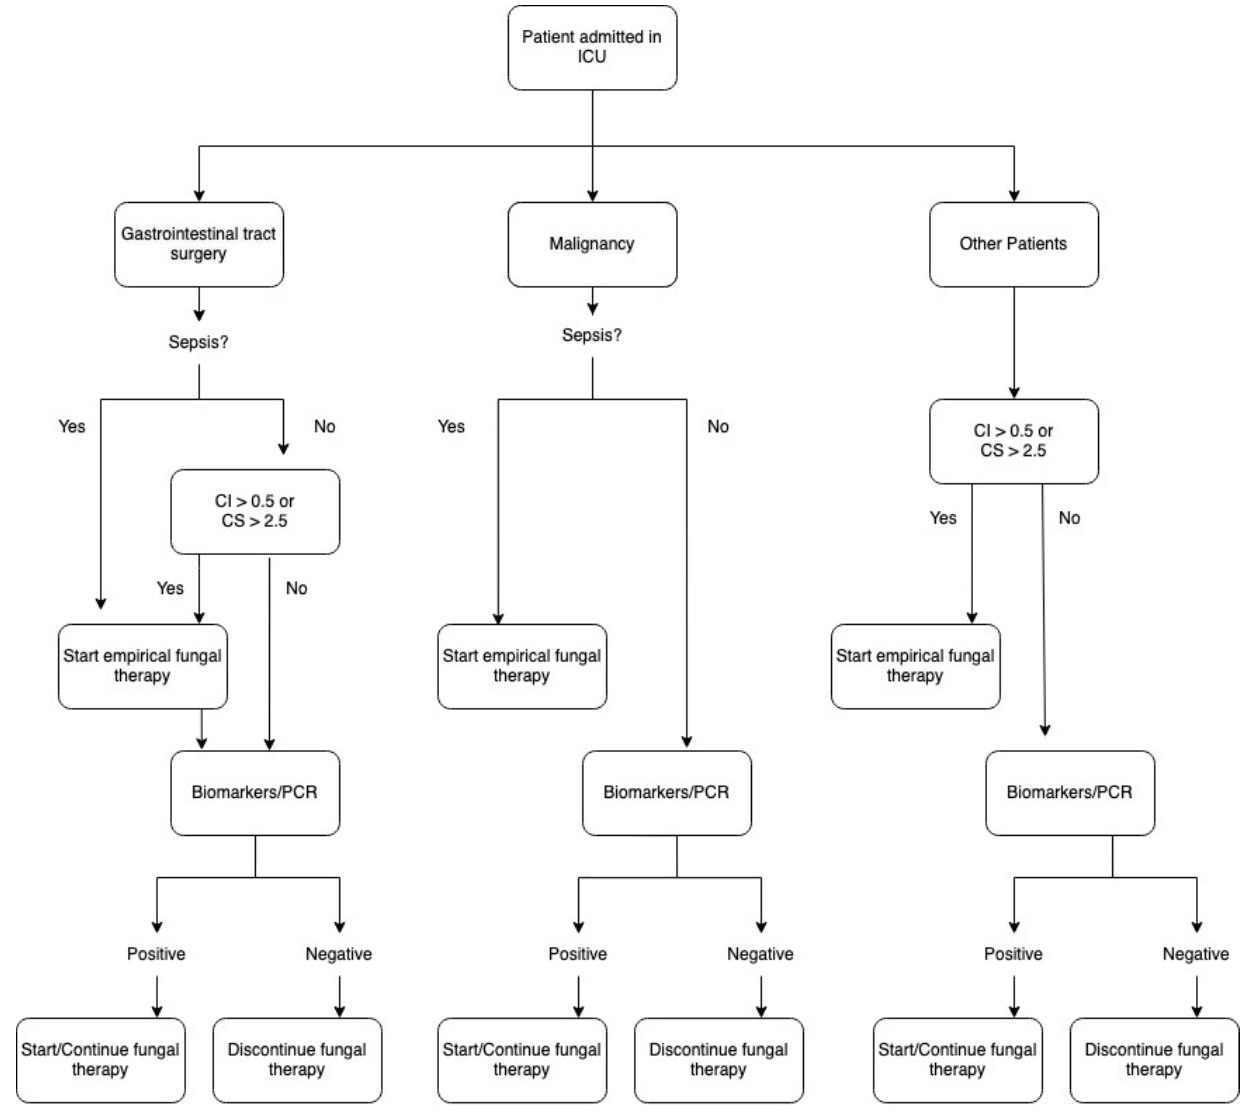
Figure 1. Proposed Algorithm for pre-emptive antifungal therapy on ICU patients who underwent intra-abdominal surgery.